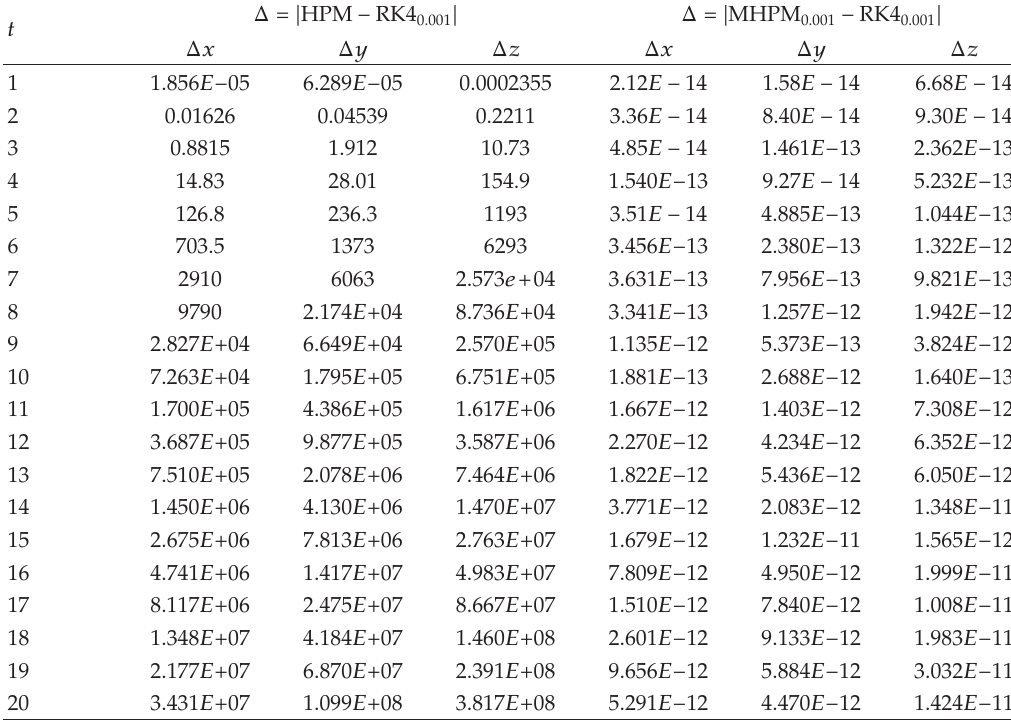
Table 2: Di ff erences between 10-term HPM and 10-term MHPM with RK4 solutions on Δ t (cid:8) 0 . 001. Δ (cid:8) | HPM − RK4 0 . 001 t